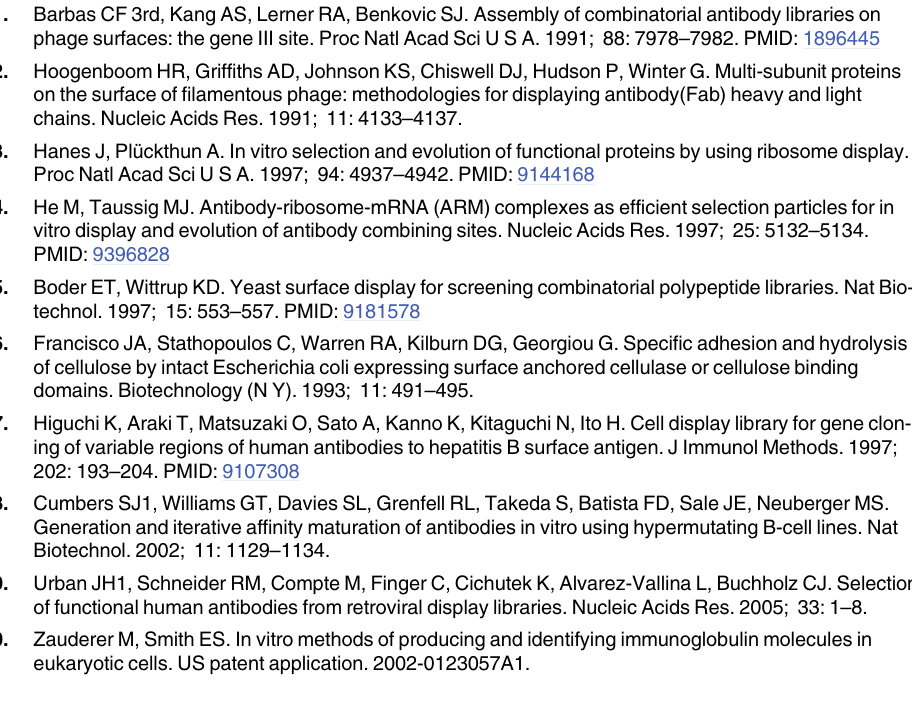
negative control protein (antigen for Clone 1). Note that clones X1-X10 do not bind to the anti- gen for Clone 1 but Clone 1 scFv.Fc show dose-dependent binding to its own antigen. The mean values for each group are derived from experiments done in triplicates and the s.d. is rep- resented by error bars. (TIF) S3 Fig. Comparison of 10 different scFv.Fc expression level in 293F cells transfected with pSplice v.4 and V.5 vectors. The mean values for each group are derived from experiments done in triplicates and the s.d. is represented by error bars. (TIF) S4 Fig. scFv.Fc of clones 1 and 2 expressed from different pSplice vectors in bacteria (A and B, respectively) and in 293F cells (C and D, respectively) do not bind to a negative control antigen. The mean values for each group are derived from experiments done in triplicates and the s.d. is represented by error bars.